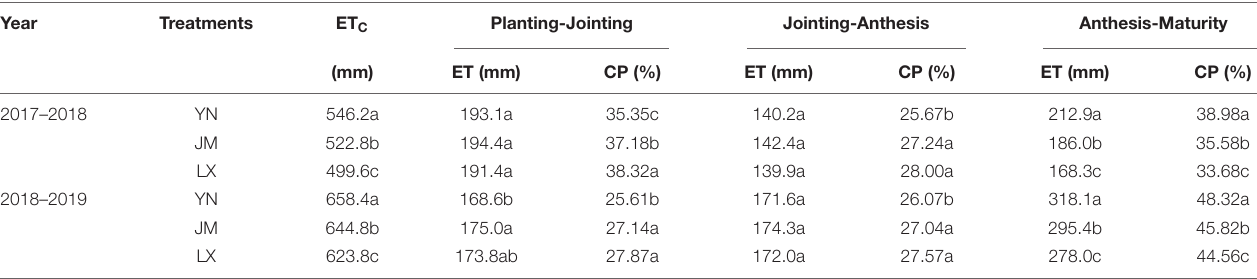
TABLE 1 | Total crop evapotranspiration during the whole growing periods of wheat (ET C ), crop evapotranspiration, and water consumption percentage in different growth periods in the 2017–2018 and 2018–2019 growing seasons. Year Treatments ET C